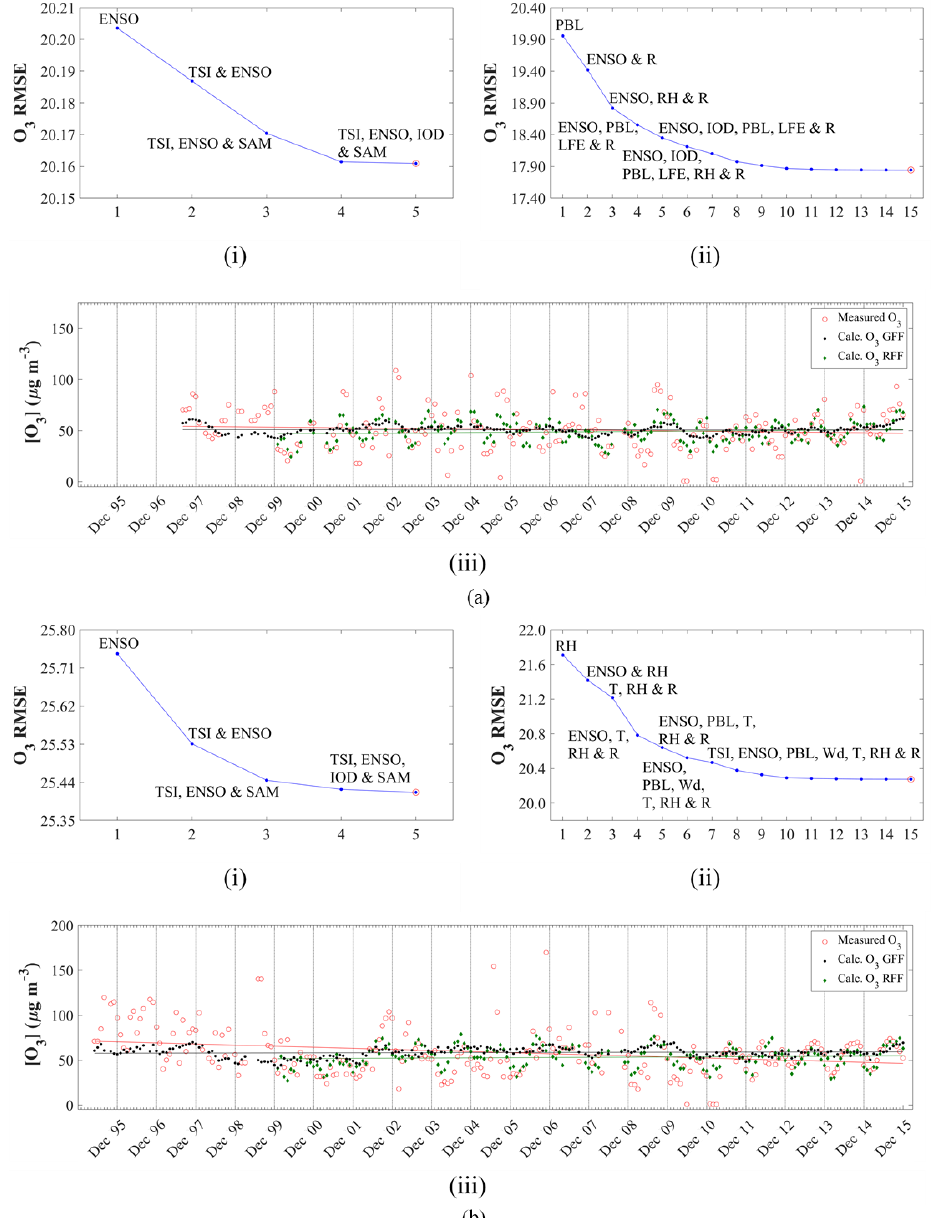
AF and LT (Fig. 11a.iii and b.iii, respectively) and a small positive slope at SK (Fig. 11c.iii). Annual average decreases in O 3 levels of 0.37 and 1.20 µg m − 3 yr − 1 were calculated at AF and LT, respectively, while an average annual increase of 0.21 µg m − 3 yr − 1 was calculated at SK. However, in gen- eral, it seems that O 3 concentrations remained relatively con- stant at all three sites for the entire 19-, 21- and 16-year sam- pling periods at AF, LT and SK, respectively. Decadal trends of − 3 . 46 (average O 3 concentrations from 1997 to 2006